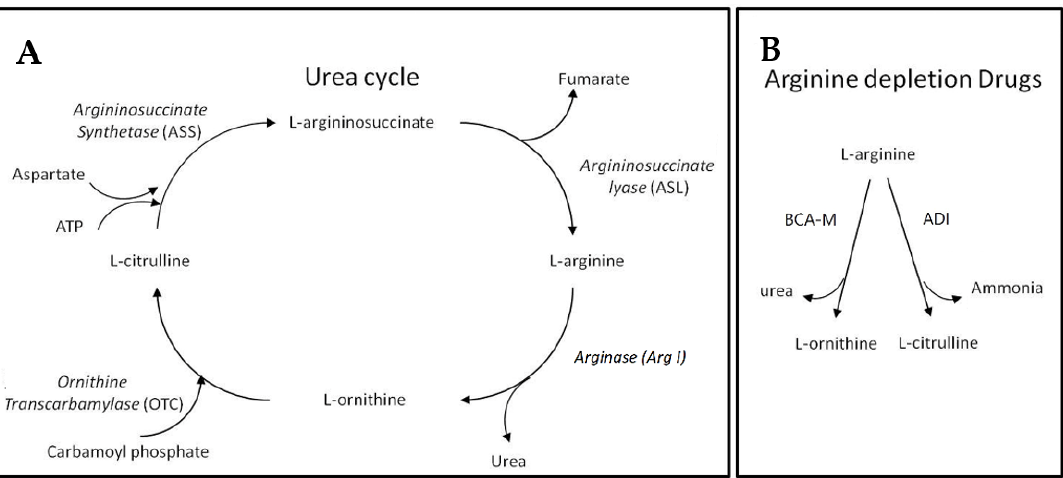
Figure 1. Urea cycle and L-arginine depletion drugs. ( A ) The urea cycle where L-arginine may be catabolized and regenerated. ( B ) The different actions of L-arginine depletion drugs resulting in different metabolites that may enter different steps of the urea cycle for L-arginine regeneration.